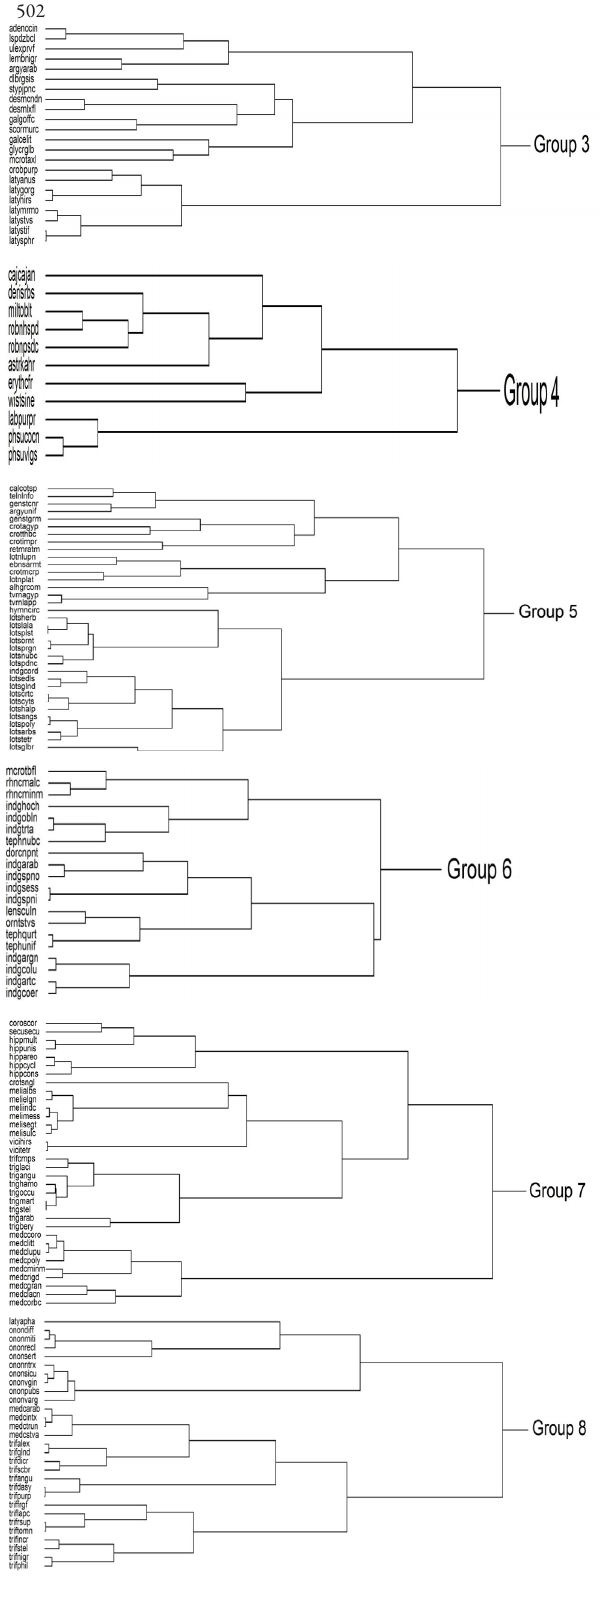
Fig. 2. The genera and species of groups 1-8 in Fig. 1. Names of taxa are abbreviated according to the list in the